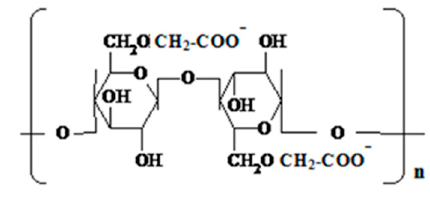
Figure 1. Carboxymethyl cellulose